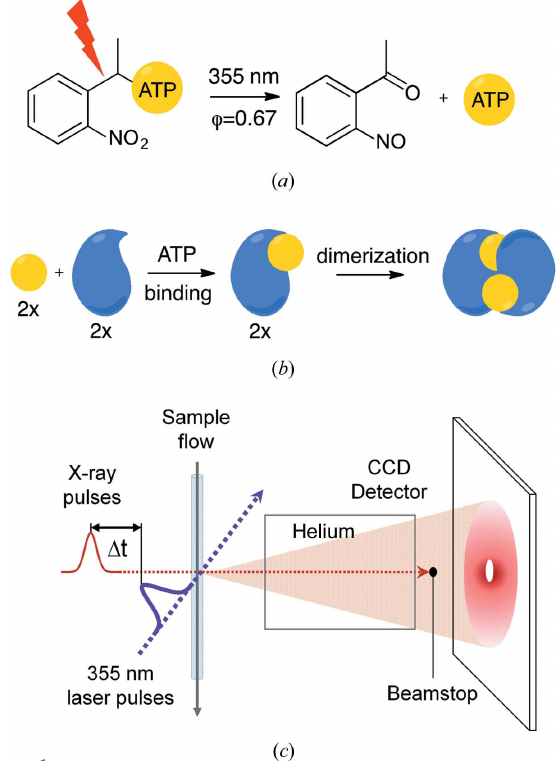
Figure 1 Overview of the experimental setup and protein structural transitions. ( a ) Photoexcited decaging of the NPE group from NPE-ATP using laser irradiation at 355 nm releases free ATP into solution. The decaging reaction happens on a 10 ms timescale. The quantum yield of the reaction is 0.67 (Syberg et al. , 2012). ( b ) Mechanism of ATP-dependent (yellow circle) dimerization of NBDs (blue). ( c ) Schematic diagram of the experimental set up at the